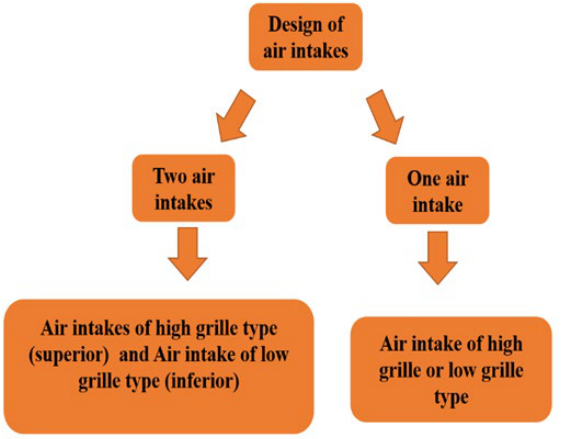
Figure 1. Design of air